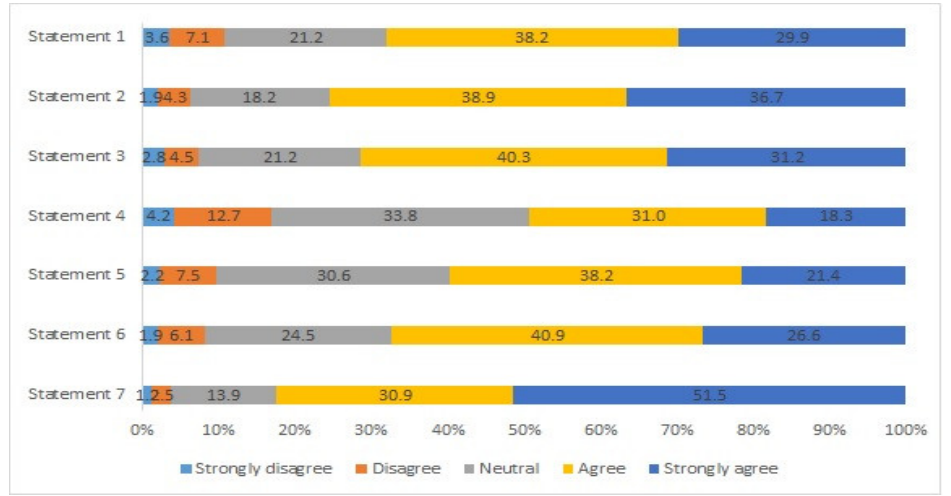
Figure 2. Consumers’ attention to companies’ green marketing communication. Source: Authors’